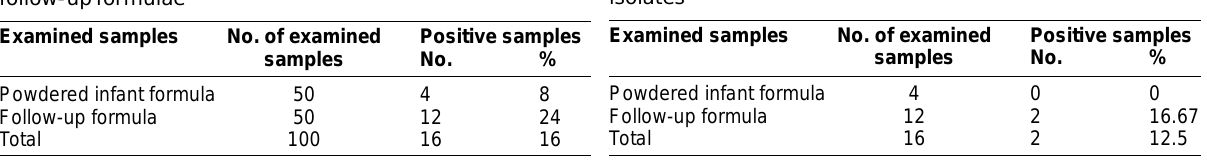
Table-2. Toxigenic type characterization of C. difficile